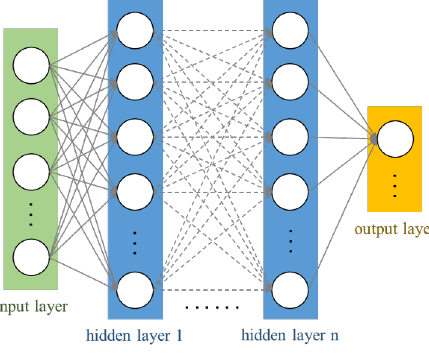
Figure 1. A basic deep neural network